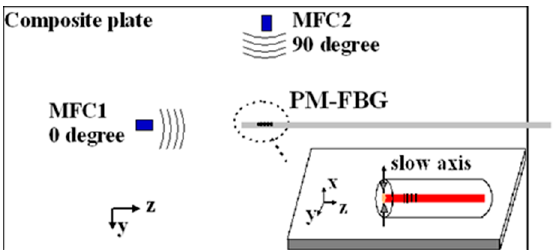
Figure 4. Polarization-maintaining Fiber Bragg grating stuck on the surface of a plate as a Lamb waves (LWs) sensor, two groups of LWs induced by Macro-fiber-composites with propagating directions parallel to and perpendicular to the axis of the sensor individually, and the slow axis of the sensor which was perpendicular to the composite plane.